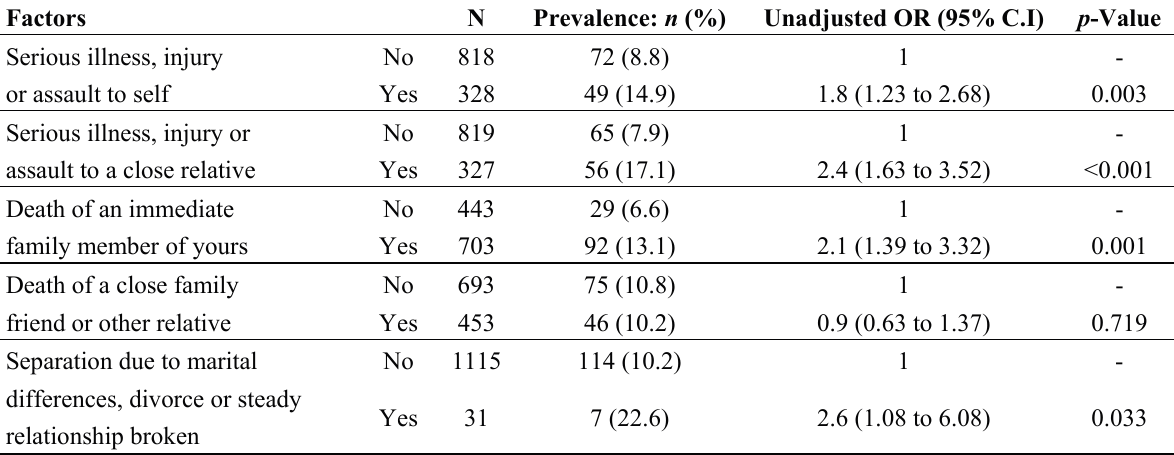
4. Relationship of probable PTSD with individual life events, using univariate